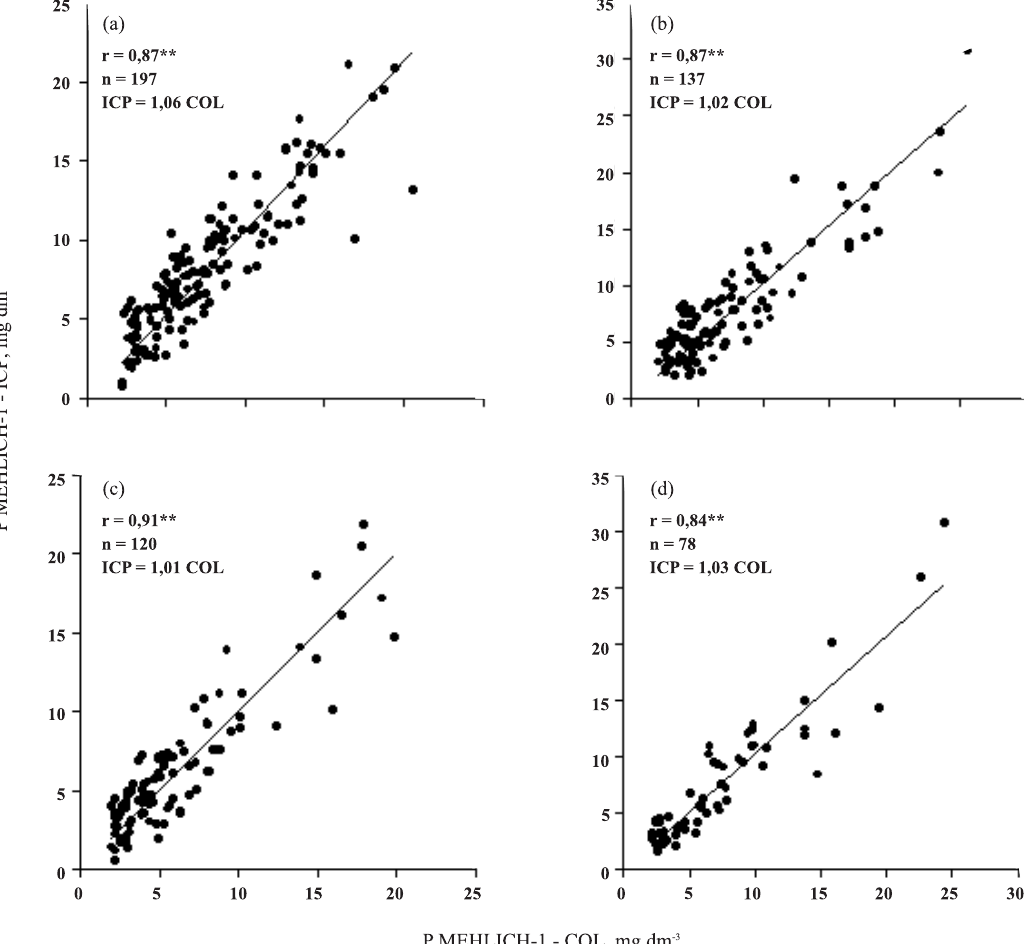
Figura 2. Relações entre os teores de P extraído pela solução de Mehlich-1, determinado por colorimetria (COL) e por ICP, conforme as classes de textura: (a) classe 1: > 60 %; (b) classe 2: 40–60 %; (c) classe 3: 20– 40 %; (d) classe 4: < 20 % de argila, respectivamente.